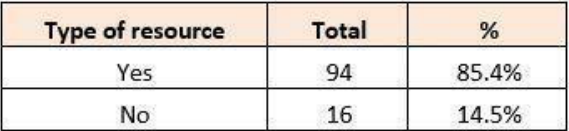
Metadata on Type of Resources